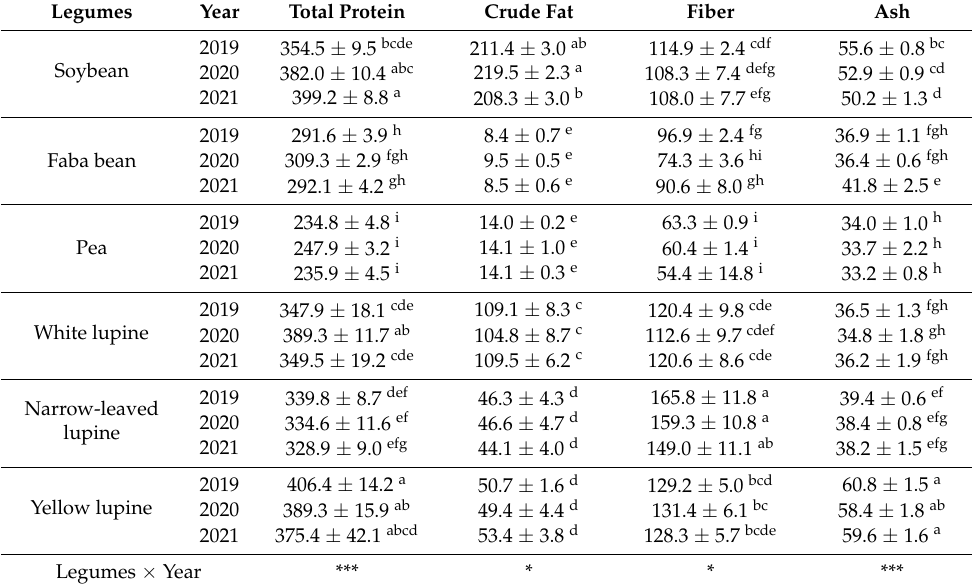
Table 2. Chemical composition of seeds in g kg − 1